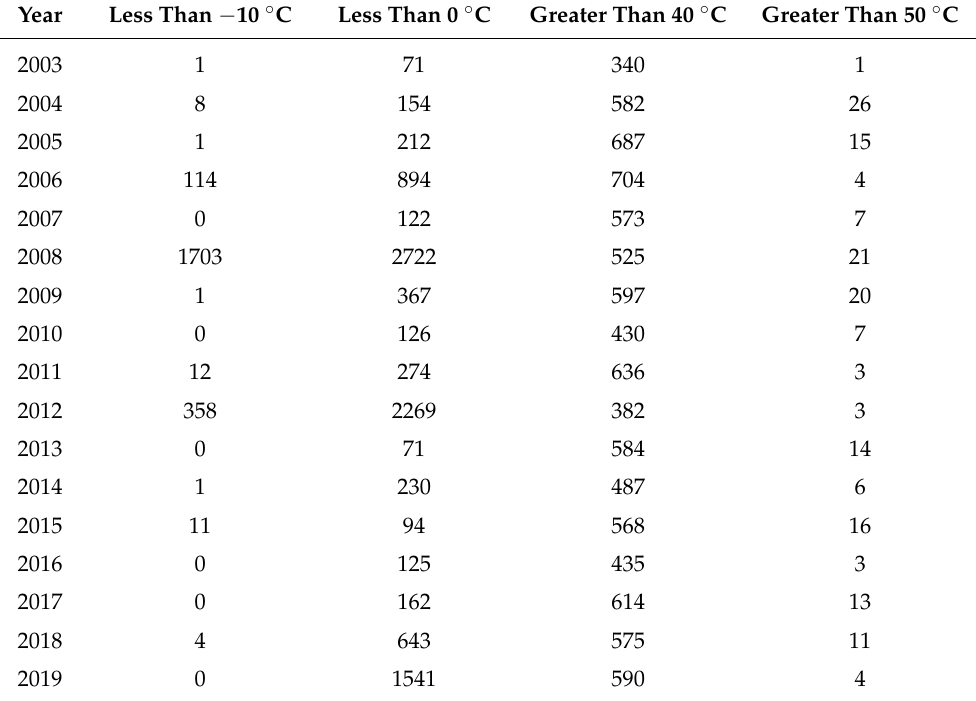
Table 6. Number of outliers in the MODIS LST data from 2003 to 2019.